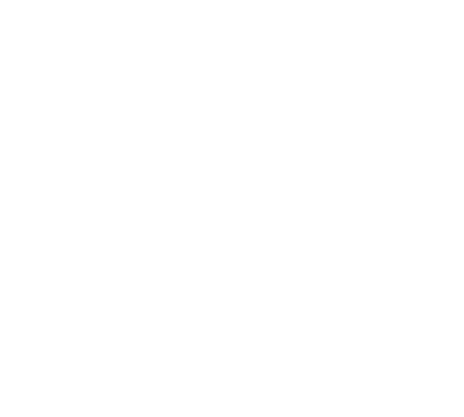
Table 2. Results of the semivariogram